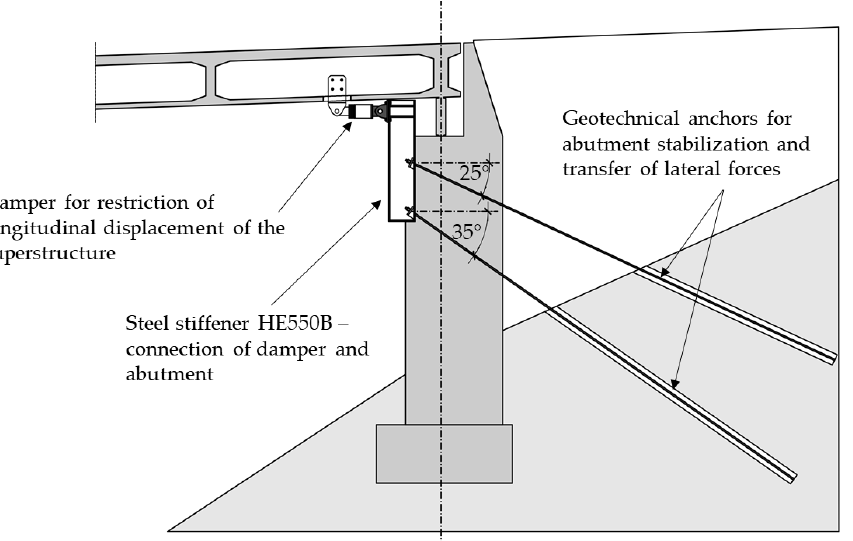
Figure 11. The proposed damper installation for the restriction of longitudinal displacement with geotechnical anchors, first Case Study bridge.